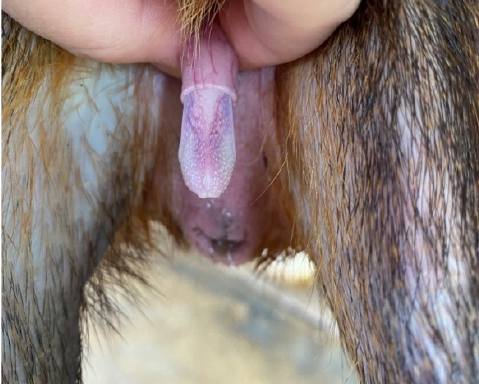
Figure 3. Penile spines visible.